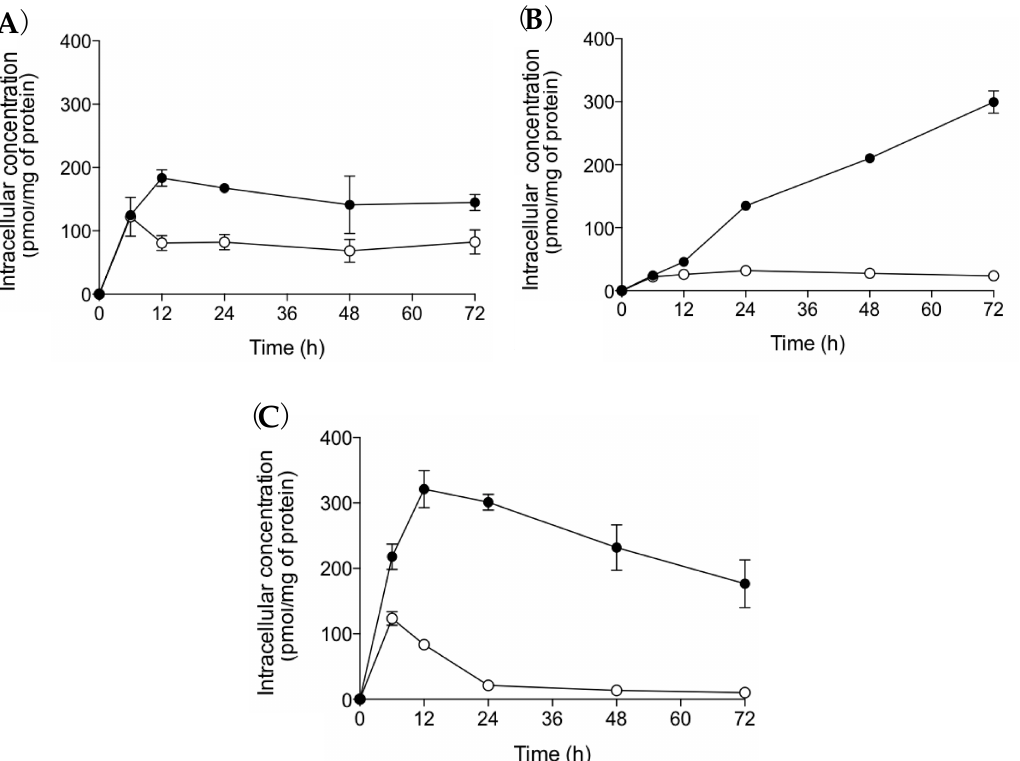
Figure 7. MKO and MK-4 levels in HaCaT cells after treatment with MK-4 or MKH derivatives. HaCaT cells were treated with ( A ) MK-4, ( B ) MKH-DMG, or ( C ) MKH-SUC (5 µ M). The intracellular concentrations of ● : MKO, and ○ : MK-4 were determined by LC-MS/MS. Data represent mean ± SD ( n = 3). Table 3. The area under curve over 72 h (AUC MKO (0-72 h) ) of MKO and (AUC MK-4 (0-72 h) ) of MK-4 concentrations and the AUC ratio of MKO to MK-4 (AUC MKO /AUC MK-4 ) over time in HaCaT cells treated with MK-4 or MKH derivatives.